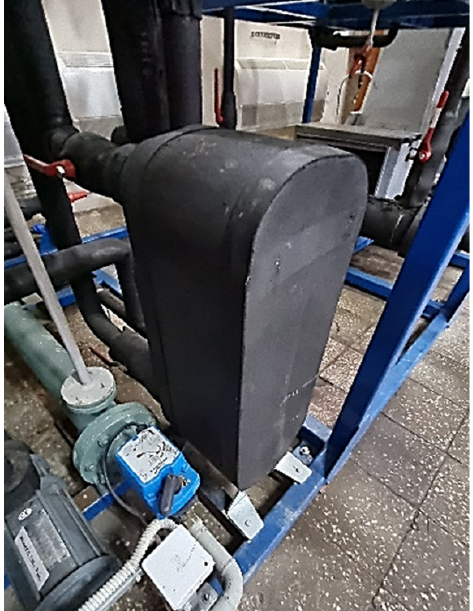
Figure 3. The plate evaporator positioning in the system. Source: own elaboration.